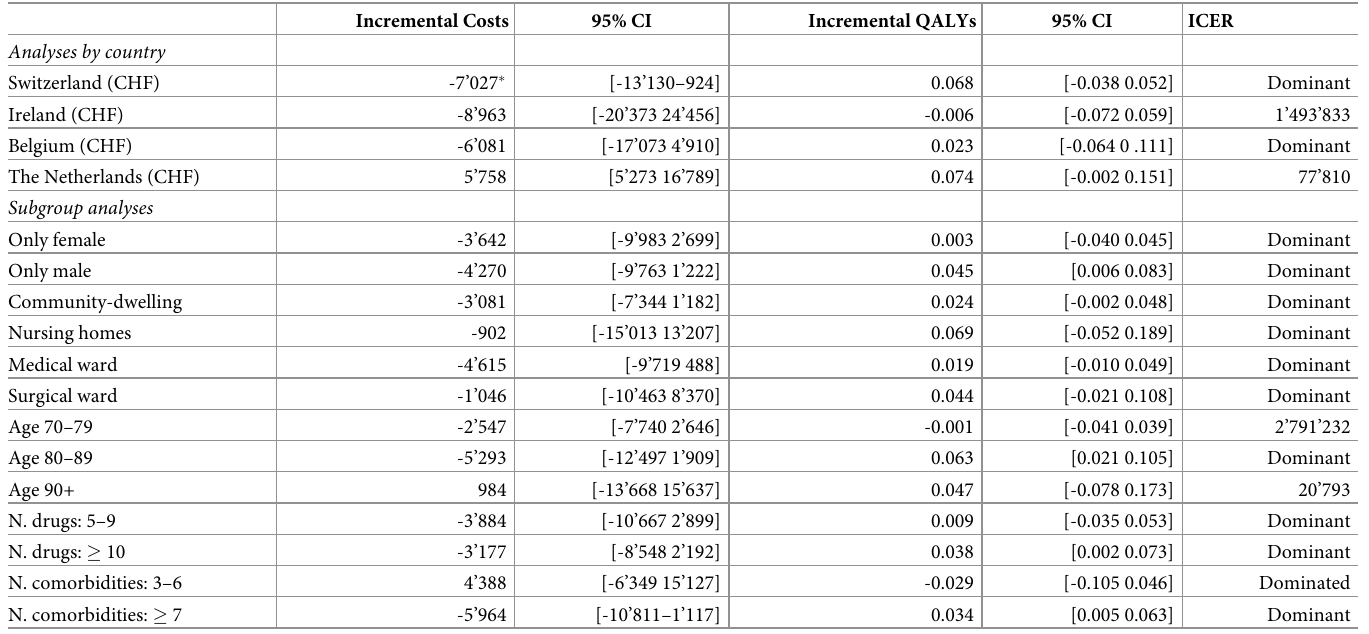
Table 4. Results of cost-effectiveness analyses for countries and subgroups, coefficients of main interest only, local costs (expressed in